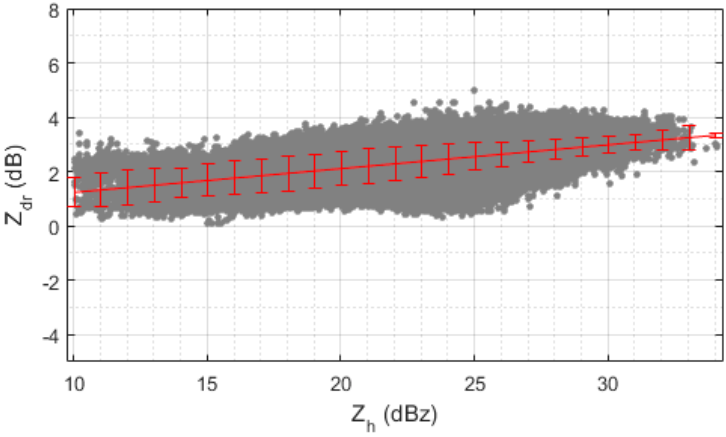
Figure 6. An example case of Z h and Z dr scatter plot and best polynomial fit for the XPRAD radar data for a rainfall event at 16:25 (BJT) on 4 June 2016. A bias of 0.481 dB was deducted from the Z dr data to perform the calibration.